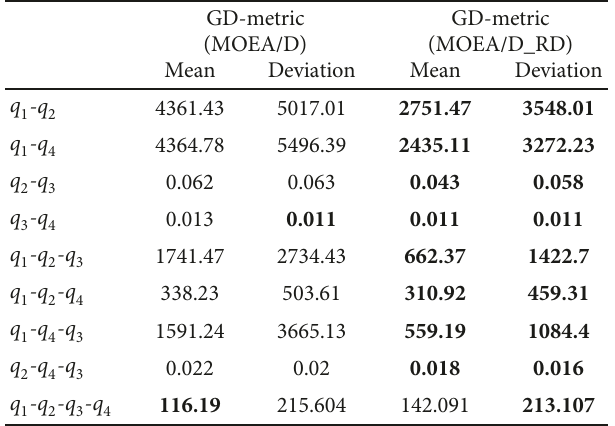
Table 3: Comparison of GD-metric of MOEA/D_RD and